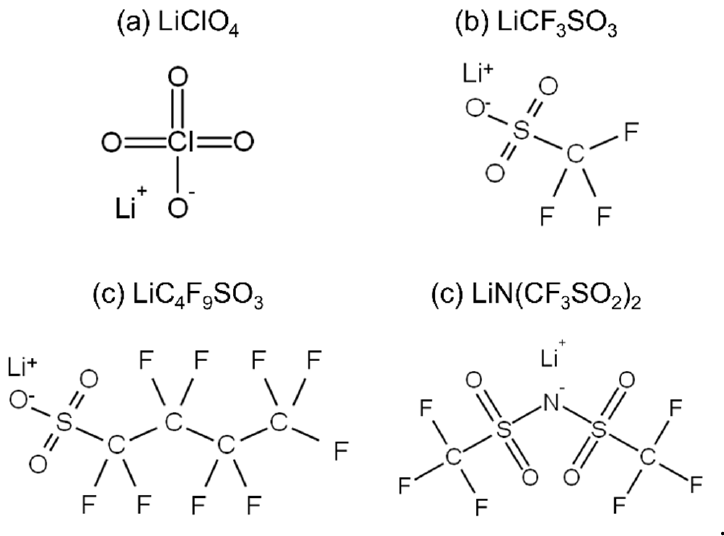
Figure 4. Lithium salts used in this study: ( a ) LiClO 4 , ( b ) LiCF 3 SO 3 , ( c ) LiC 4 F 9 SO 3 , and ( d ) LiN(CF 3 SO 2 ) 2 .